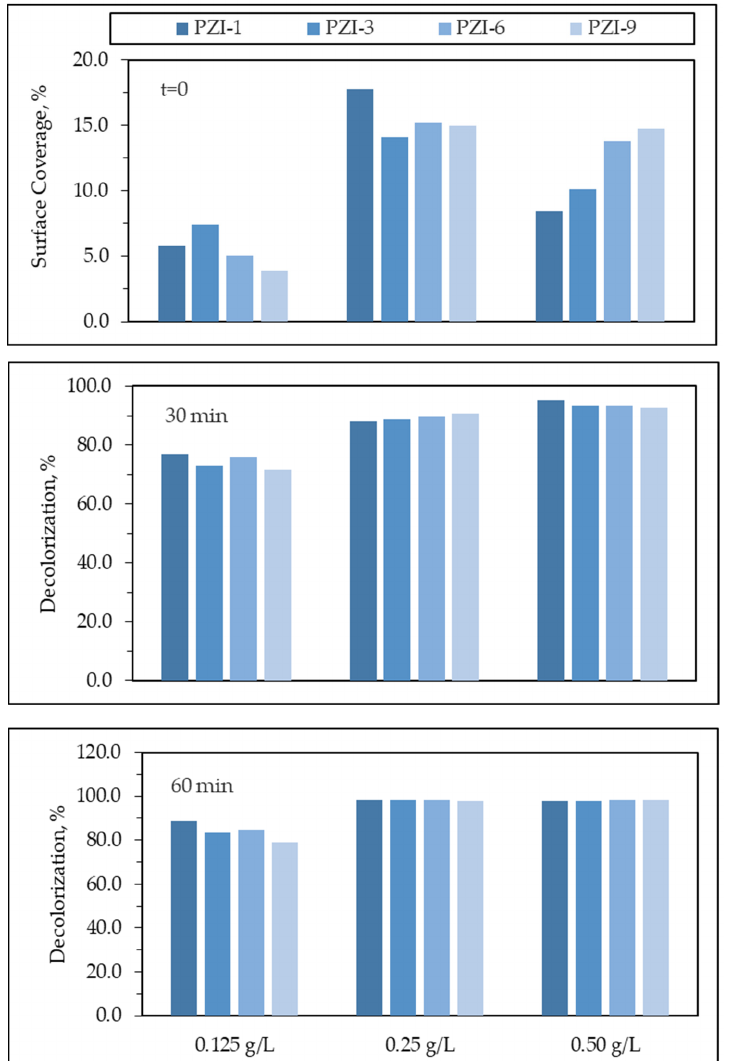
Figure 11. Photocatalytic degradation of MB upon use of PZI specimens: Dose effect.